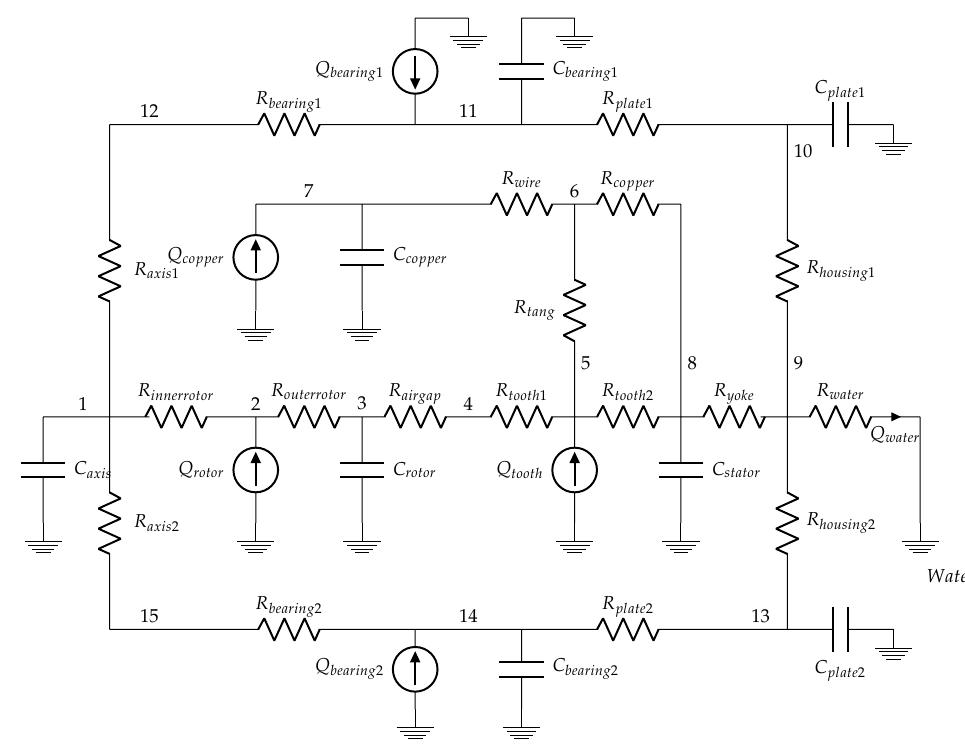
Figure 5. Thermal model of a permanent-magnet synchronous